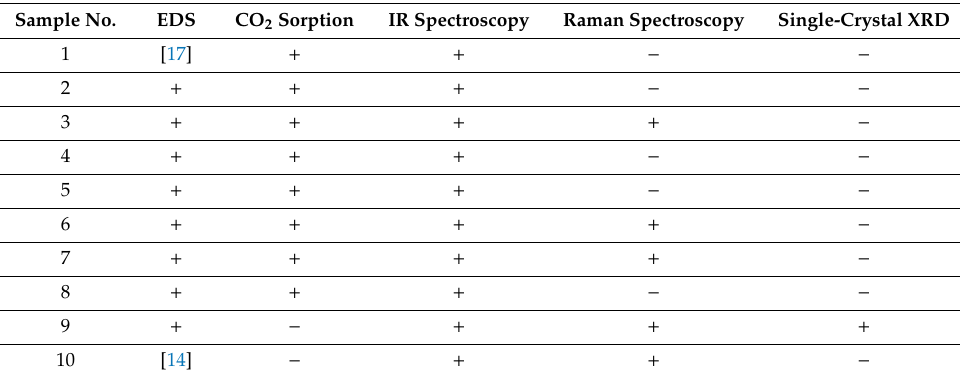
Table 1. Techniques applied for the characterization of Samples 1 to